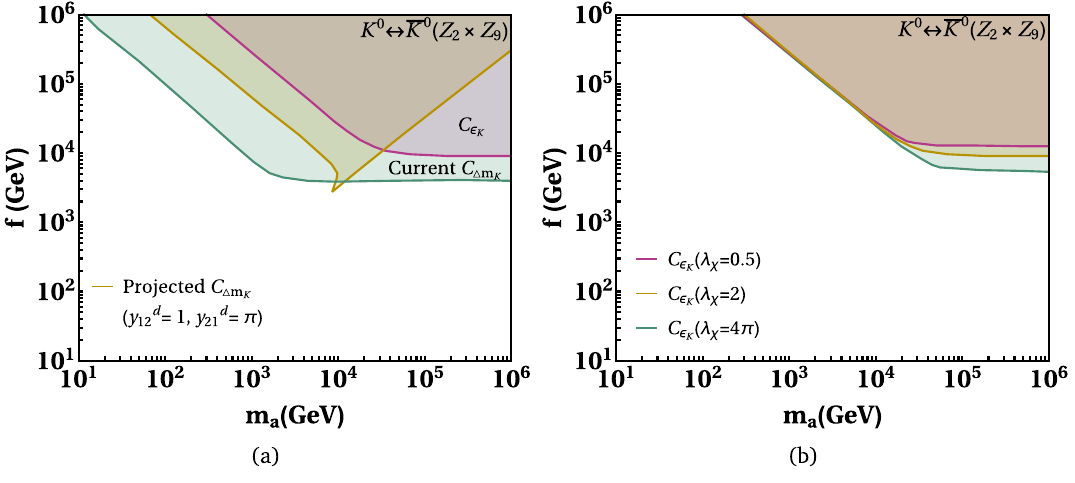
Fig. 2 The allowed parameter space by flavour observables C (cid:7) and respectively. Also, the allowed bound with projected limits of C (cid:15) m K C (cid:15) m shown with olive coloured boundary. The effect of the variation of the inthe m a − f planeforthenon-minimal Z 2 × Z 9 flavoursymme- K quartic coupling λ χ on the observable C (cid:7) try. On the left panel in a , the allowed bounds for λ χ = 2 with current limits for C (cid:15) m in b and C (cid:7) are shown by green and magenta boundaries, K K Fig. 3b, by magenta and green coloured boundaries, respec- tively.Wenotethattheregionintheleftpanel,boundedbythe blue curve, represents the allowed bounds for the observable C B with projected limits of LHCb Phase-II for the mini- s mal model, while the same for the non-minimal model is shown by the region surrounded by the olive coloured curve in the right panel. For the LHCb phase-I, the bounds are Fig.4b.IntheleftpanelinFig.4a,theredandyellowcoloured shown by the pink coloured curves for the minimal as well boundaries are representing allowed flavon contribution as for the non-minimal models, which are not appreciably different than that of the LHCb phase-II. We also notice an isolated allowed strip of the parameter space for the non- minimal model below the green boundary in the right panel.